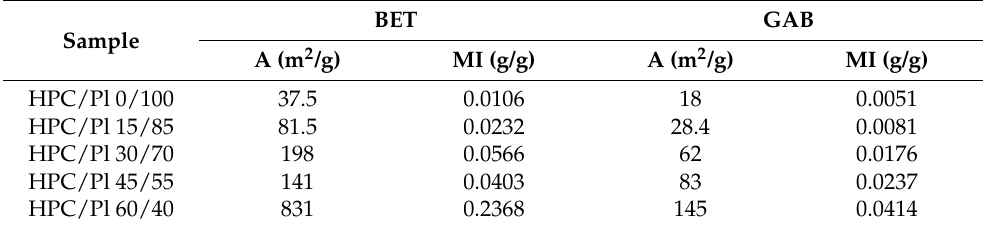
Table 3. Surface parameter values estimated on the basis of BET and GAB